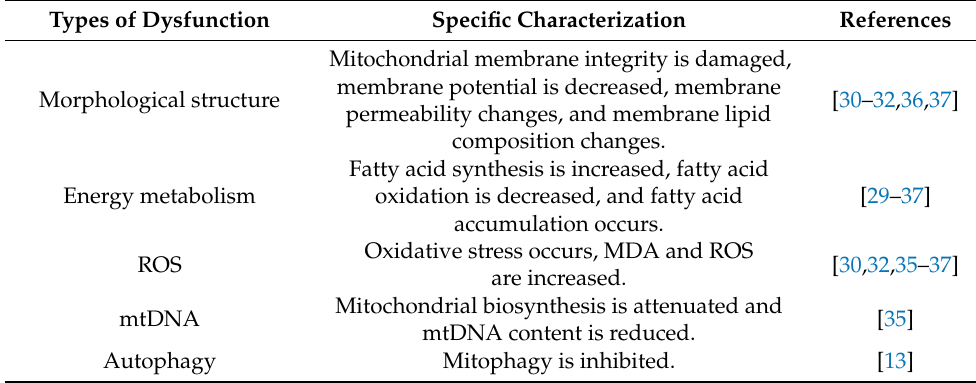
Table 2. Characterizations of mitochondrial dysfunction in